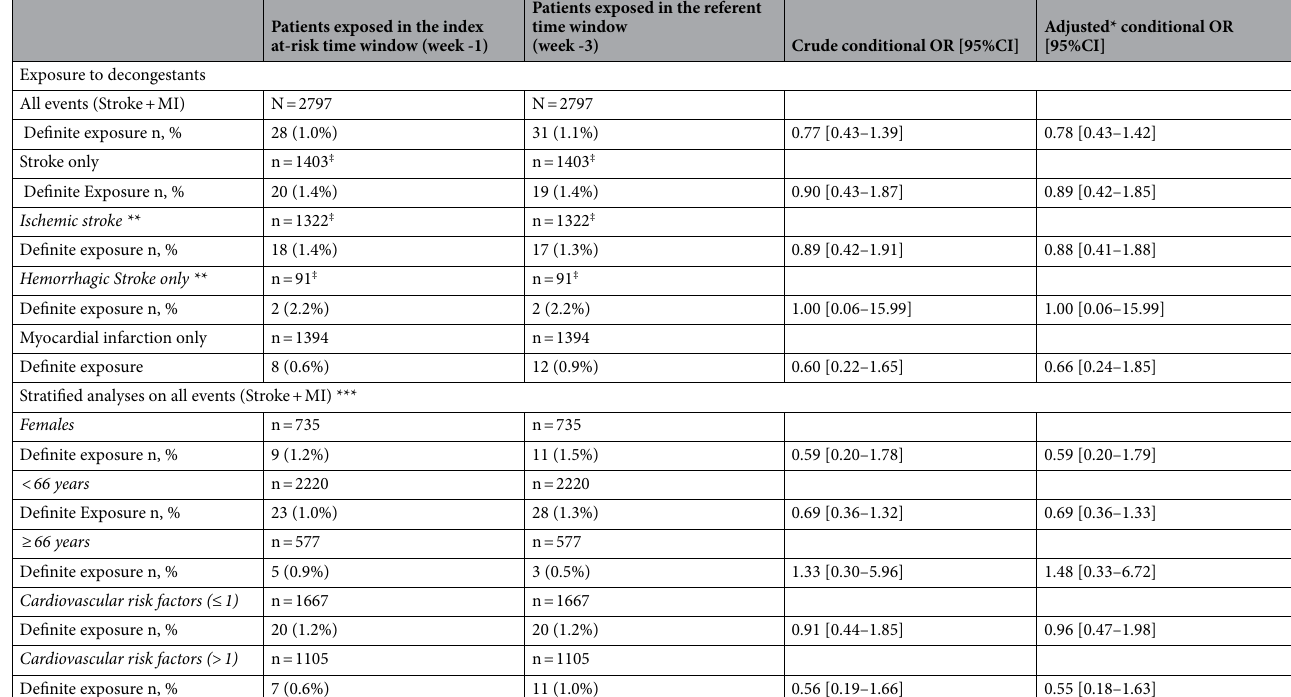
Table 2. Association between definite exposure to decongestants and the odds of incident myocardial infarction or stroke, pooled or separated and by gender and age. *Adjusted odds ratio estimated using conditional logistic regression models including potential time-varying confounders (respiratory-tract infections (pneumonia or bronchitis), urinary-tract infections (cystitis, pyelonephritis, or prostatitis), dental infections, and local anesthesia (applied by a dentist, ENT specialist, or pulmonologist) included in one dichotomous yes/no composite confounder variable (yes if any of the four corresponding events occurred, no otherwise), with “No exposure” as the reference. **Including 10 cases with ischemic and hemorrhagic stroke. ***Exploratory analysis. CI confidence interval, MI myocardial infarction; OR odds